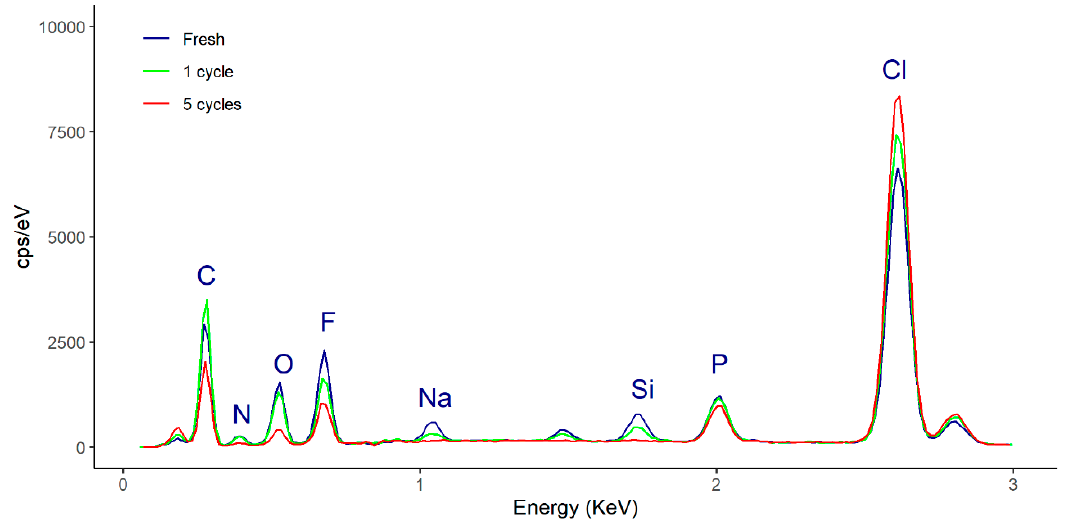
Figure 8. EDX spectra of the ionogel enzymatic derivative (Enz-ionogel-B): ( a ) fresh (blue line), ( b ) after 1 cycle (green line), and ( c ) after 5 cycles (red line).